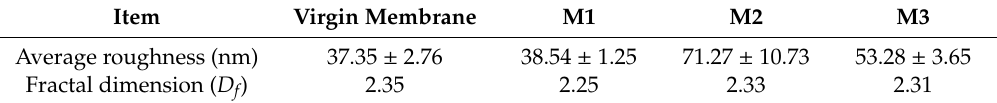
Table 1. Roughness parameters and fractal dimensions during the di ff erent membrane fouling stages. Item Virgin Membrane M1 M2